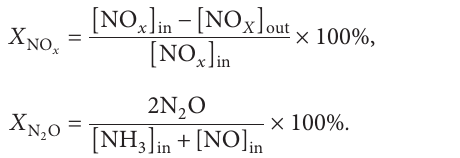
Figure 1. The catalyst was fixed in the middle of the reaction tube and the tests of the SCR reaction temperature were controlled by the program precision temperature controller (YuDian AI-708). A Mass flowmeter was applied to regulate the concentrations of feed gas. H O was provided by a 2 syringe pump (EverSeiko, 022 Pulsation Control Single) and mixed with the feed gas in the